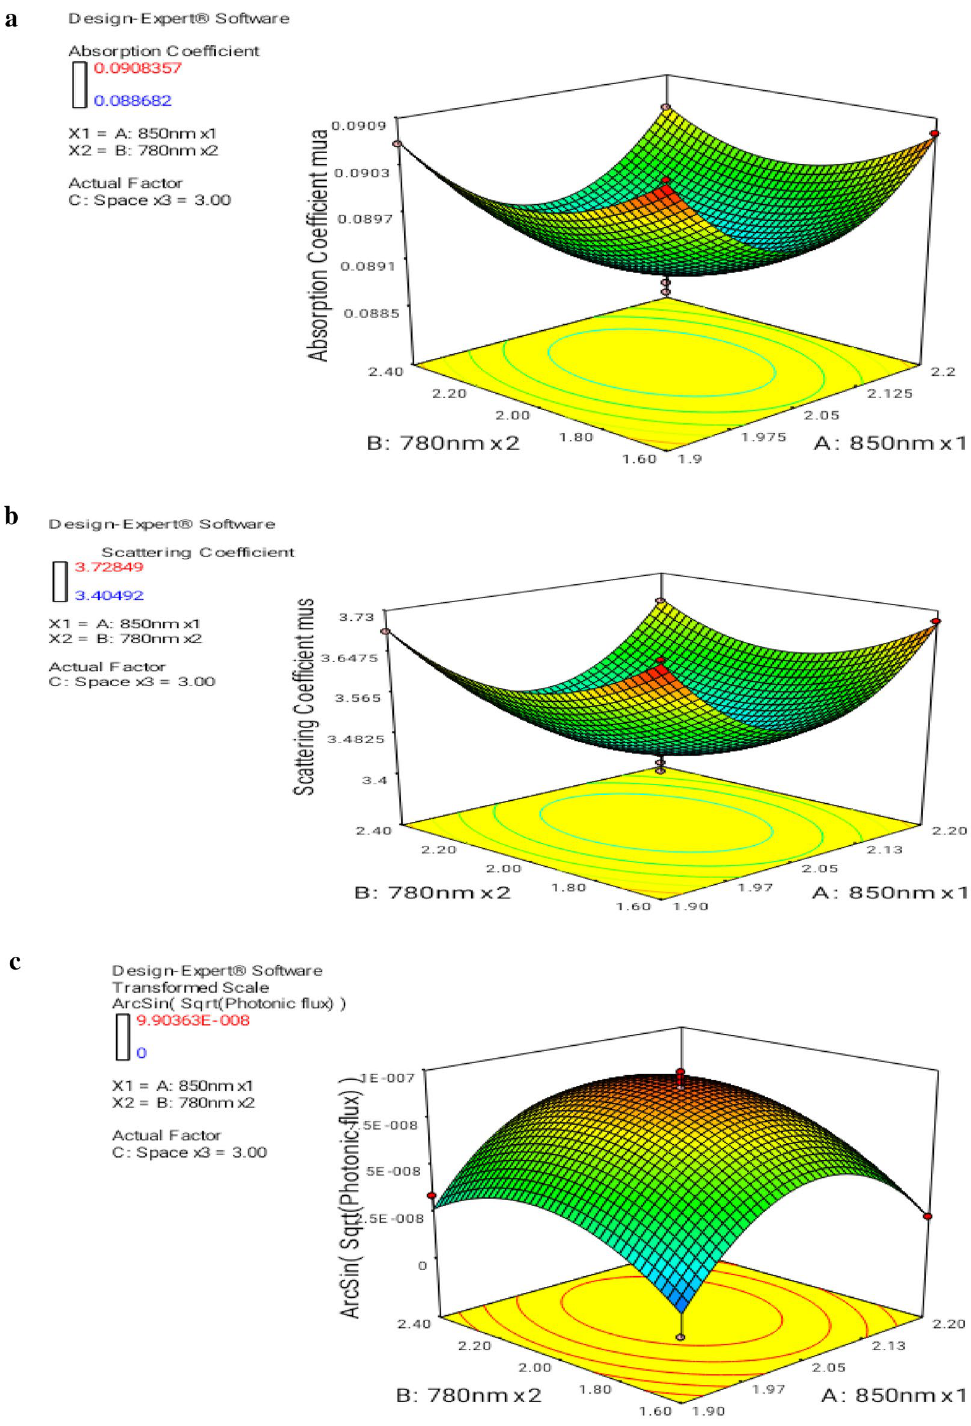
Figure 7. ( a ) 3D plot interaction of A and B for mua—displays the response mua based on the interaction of three numeric factors. ( b ) 3D plot interaction of A and B for mus—displays the results of mus based on the interaction of three numeric factors. ( c ) 3D plot interaction of A and B for phi—displays the response phi based on the interaction of three numeric